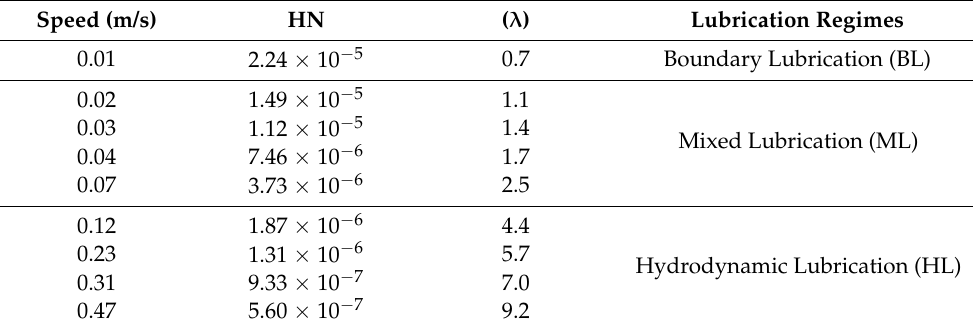
Table 4. Hersey number (HN), Tallian parameter ( λ ), and different lubrication regimes as a function of the sliding speed